Question: Reading the figure, is the described quantity rising or falling?
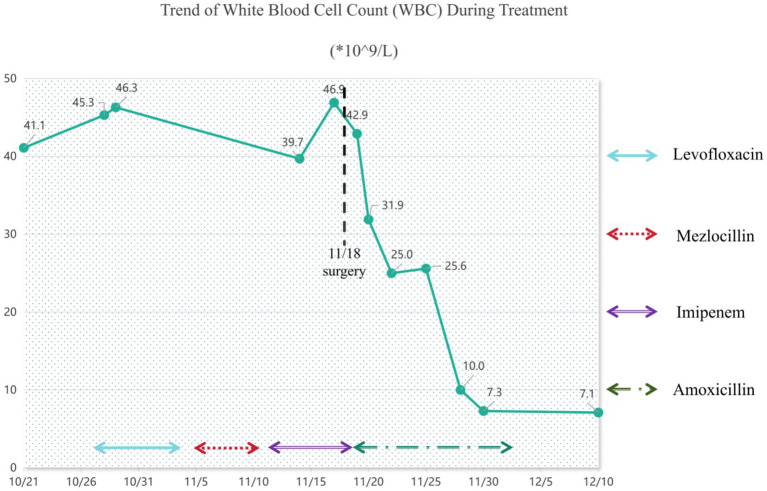
Answer: decreasing